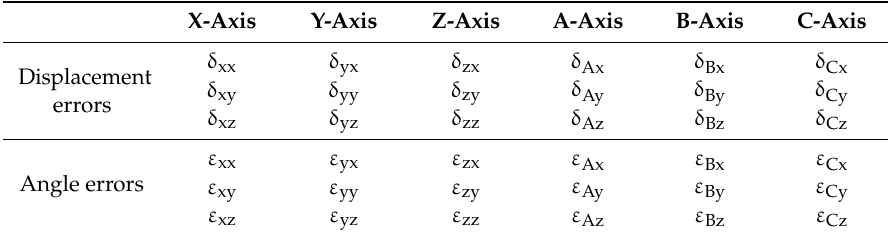
Table 1. Geometric errors of multi-axis machine tools.